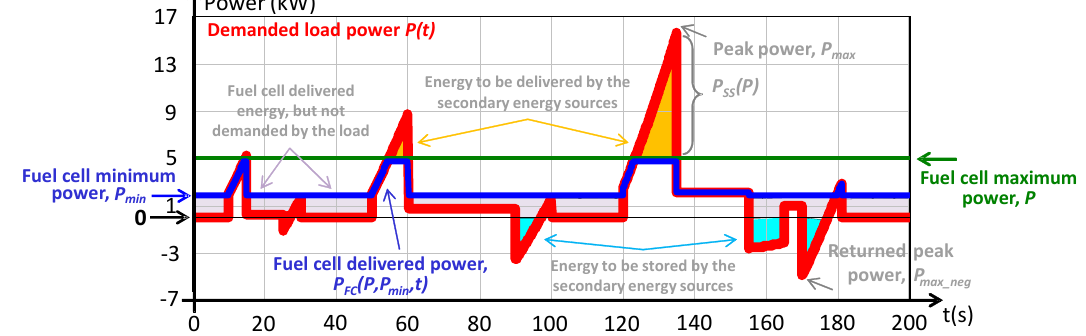
Figure 1. Demanded power by the load during one ECE-15 driving cycle.